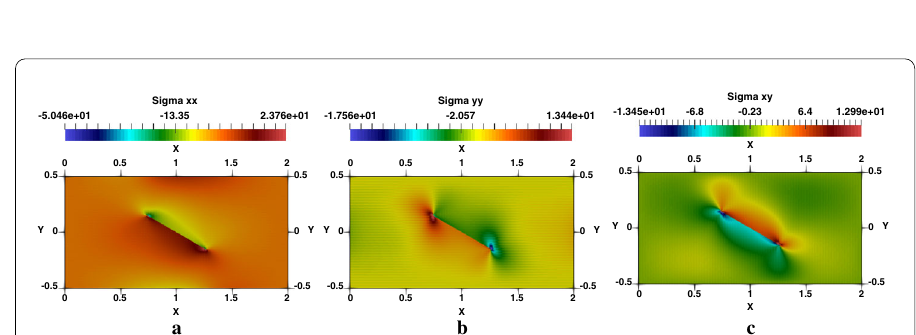
Fig. 10 Rectangular plate with inclined crack, β = 30 ◦ and a / W = 0 . 3: a σ xx -stress, b σ yy -stress, c σ xy -stress